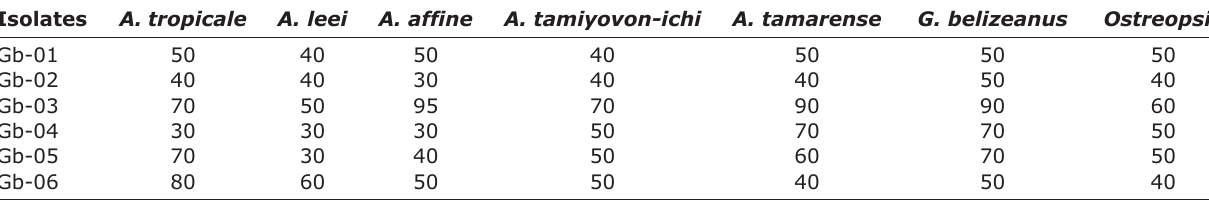
A. tropicale=Alexandrium tropicale, A. tamarense=Alexandrium tamarense, A. leei=Alxandrium leei, A. affine=Alxandrium affine, A. tamiyovon-ichi=Alexandrium tamiyovon-ichi, G. belizeanus=Gambierdiscus belizeanus , NB=Nutrient broth